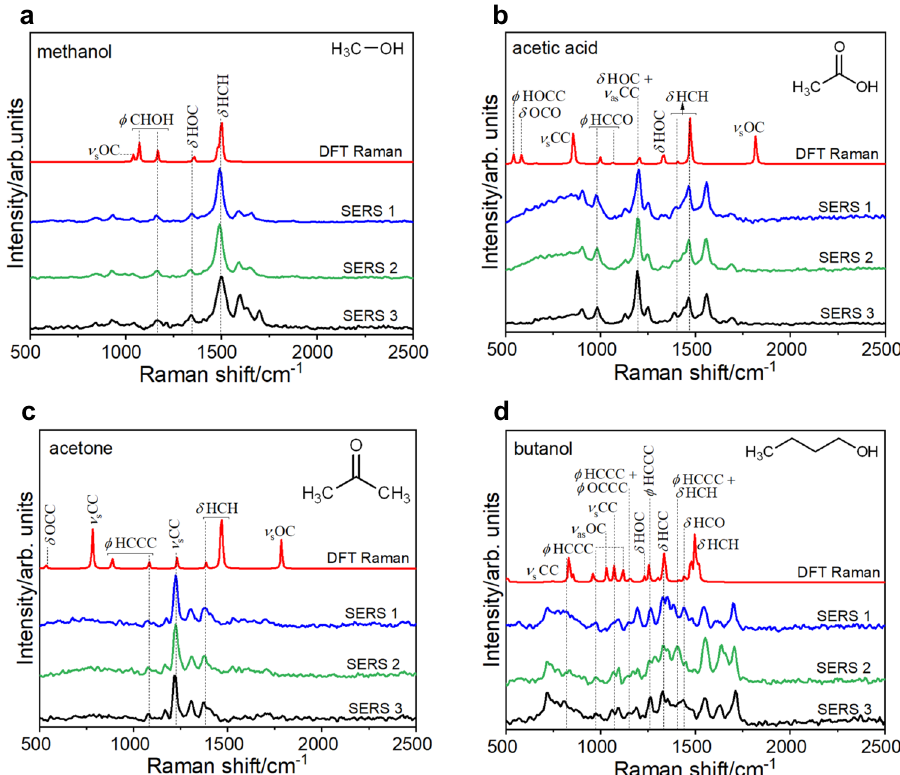
Fig. 2 Species detected on Ag NPs in the course of plasmon-excitation-driven CO 2 RR in water. Three representative examples of measured SERS spectra (blue, green, and black traces) that correspond to the detection of a methanol, b acetic acid, c acetone, and d butanol. In each case, the DFT-calculated Raman vibrational spectrum, which served as the basis of the assignment of the measured SERS spectra, is also shown by the red trace. The major vibrational modes are labeled using the following symbols: ϕ — torsion; ν s — symmetric stretching; ν as — asymmetric stretching; δ — bending. Spectra are shown vertically stacked for clarity. SERS spectra were baseline-subtracted, subjected to smoothing by a Savitzky – Golay fi lter with a window of 5 points and a polynomial of order 3, and normalized to a [0, 1] scale prior to plotting in a vertically stacked manner. The baseline was determined by polynomial fi tting. DFT-computed Raman spectra were normalized to a [0, 1] scale, and the y -axis quantity was magni fi ed (by a scale factor of 4 in a , b and a factor of 10 in c , d ) prior to plotting. Source data are provided as a source data fi